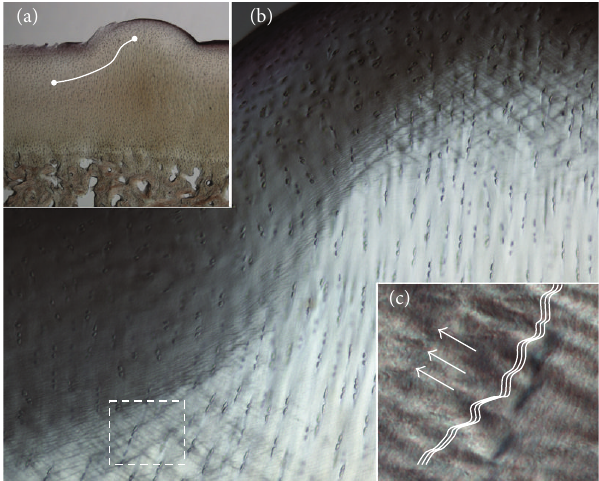
Figure 6: A more detailed view of an SR7 group sample, from the directly loaded region to the bulge region. (a) The white line indicates the span of the region shown at higher magnification in (b). Shear bands are visible as patterns of oblique-crisscross lines. The boxed region (dashed line) in (b) is greatly enlarged in (c) to show the structure of the shear bands. The wave feature represents an in-phase fibrillar compression (crimp) with the arrows indicating the overall direction of this crimp, forming part of the crisscross pattern visible at the larger scale view. DIC imaging.